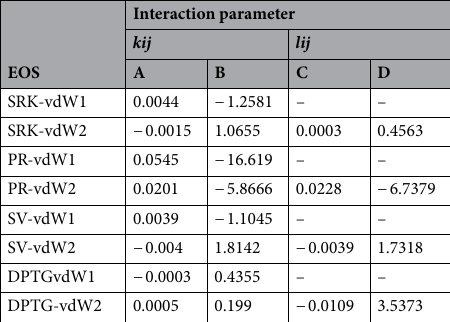
Table 4. Adjustable parameters determined by linear regression